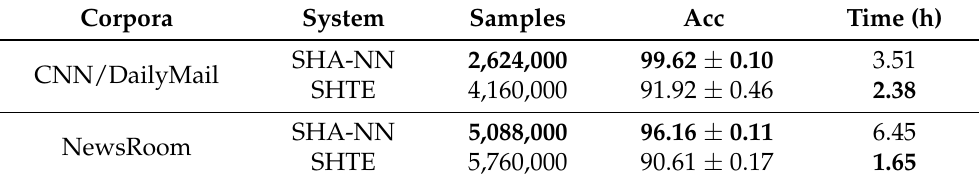
Table 5. Convergence statistics of our systems. Best results are in bold.